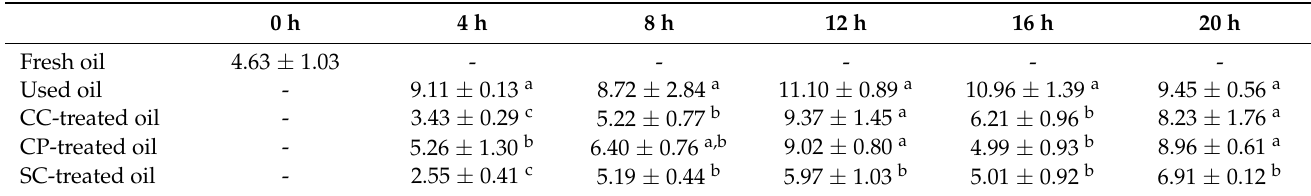
Table 4. Peroxide values (meq O 2 /kg) of the used and treated oils with different lignocellulosic biomasses; corn cob (CC), cornstalk piths (CP) and sugarcane bagasse (SC). Means with different letters ( a , b , c ) within each column indicate statistically significant differences between the samples after Duncan’s analysis ( p < 0.05). The numbers 4, 8, 12, 16 and 20 indicate the frying period by (h, hours).